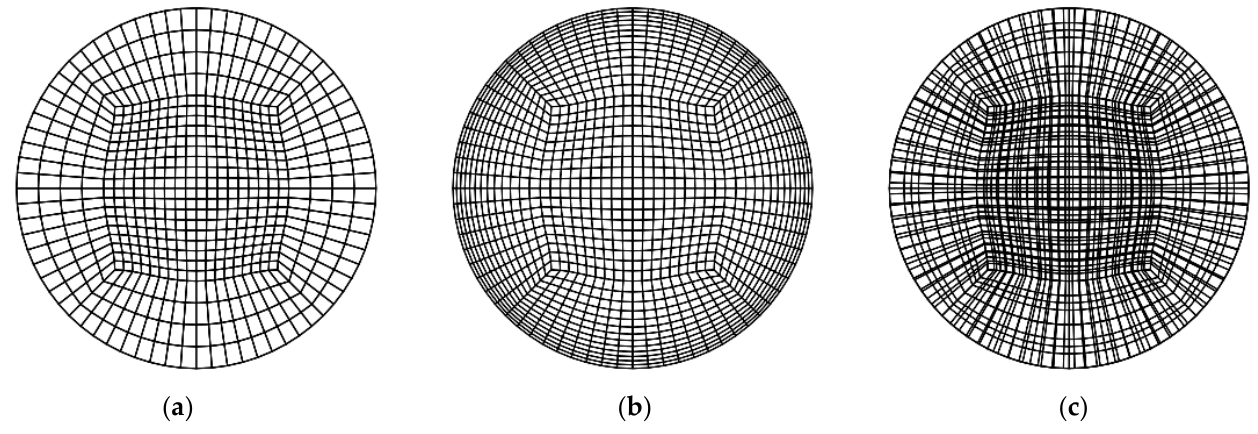
Figure 3. Grid arrangement of xz-plane slice, where the grid numbers are 65,500 ( a ), 126,000 ( b ), and 183,700 ( c ), respectively.